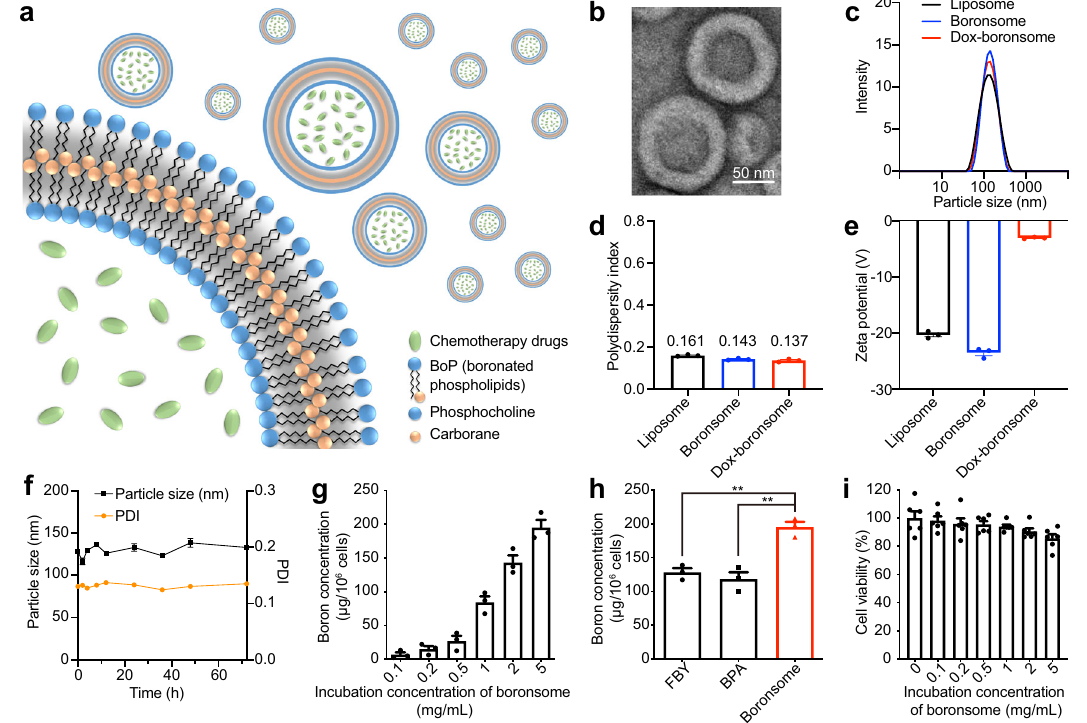
Fig. 3 Boronsome is an ef fi cient platform for boron and chemotherapy drug delivery. a Schematic illustration of chemotherapeutic agents encapsulated carboranyl-lipid boronsomes. b Representative TEM images of boronsomes. Three independent experiments were performed and representative results are shown. Scale bar, 50 nm. c-e Dynamic light scattering size c , PDI d and zeta potential e of liposomes, boronsomes and Dox-boronsomes ( n = 3). f Boronsomal stability in 50% FBS. The size and PDI ( n = 3) were measured at different time points. g Boron concentration ( n = 4) of 4T1 cells after incubation with various concentrations of boronsome for 24 h. h Boron concentration ( n = 4) of 4T1 cells after incubation with FBY, BPA and boronsomes for 24 h at the same boron dose (two-tailed unpaired Student ’ s t test, FBY vs Boronsome: ** p = 0.0027, BPA vs Boronsome: ** p = 0.0040). i Survival fraction ( n = 6) of 4T1 cells under various concentrations of boronsome after 24 h. Data are means± SEM. Source data are provided as a Source Data fi